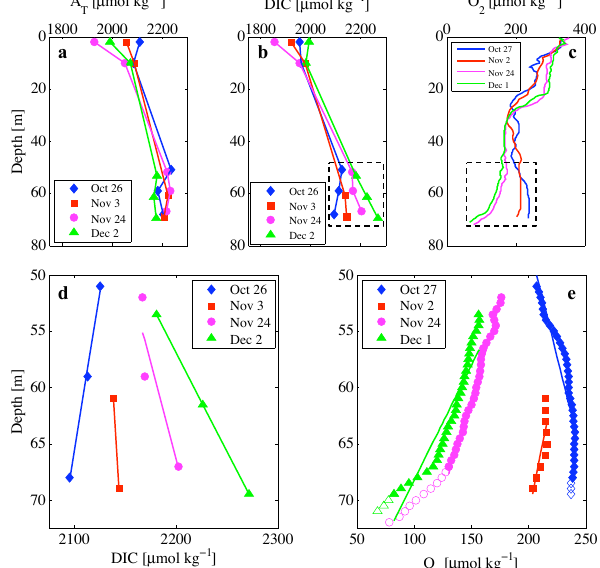
Fig. 6. Top: vertical profiles of A T (a) , DIC (b) , and O 2 (c) in Bed- ford Basin. Black dashed boxes indicate deep-water samples shown in bottom panels. Bottom: vertical profiles of DIC (d) and O 2 (e) in deep waters with least-square regression lines indicating gradients. For deep-water O 2 profiles (e) , linear regressions are done over the same depth ranges as used for DIC (d) in order to be consistent with the depth ranges used to deduce the slopes. Open markers in- dicate deeper samples not used in the regressions. It is clear that the CTD-based O 2 sensor provides a better resolution of the near- sediment gradients, which cannot be resolved with the 30L Niskin bottle used for sampling DIC and 224